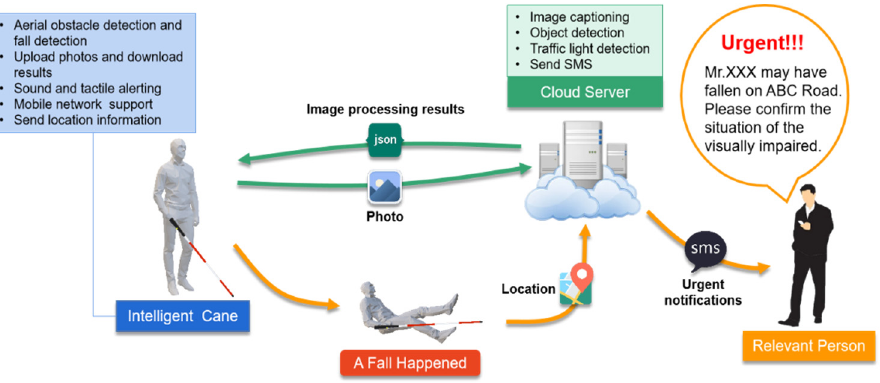
Figure 1. Interactions of the components of the framework.